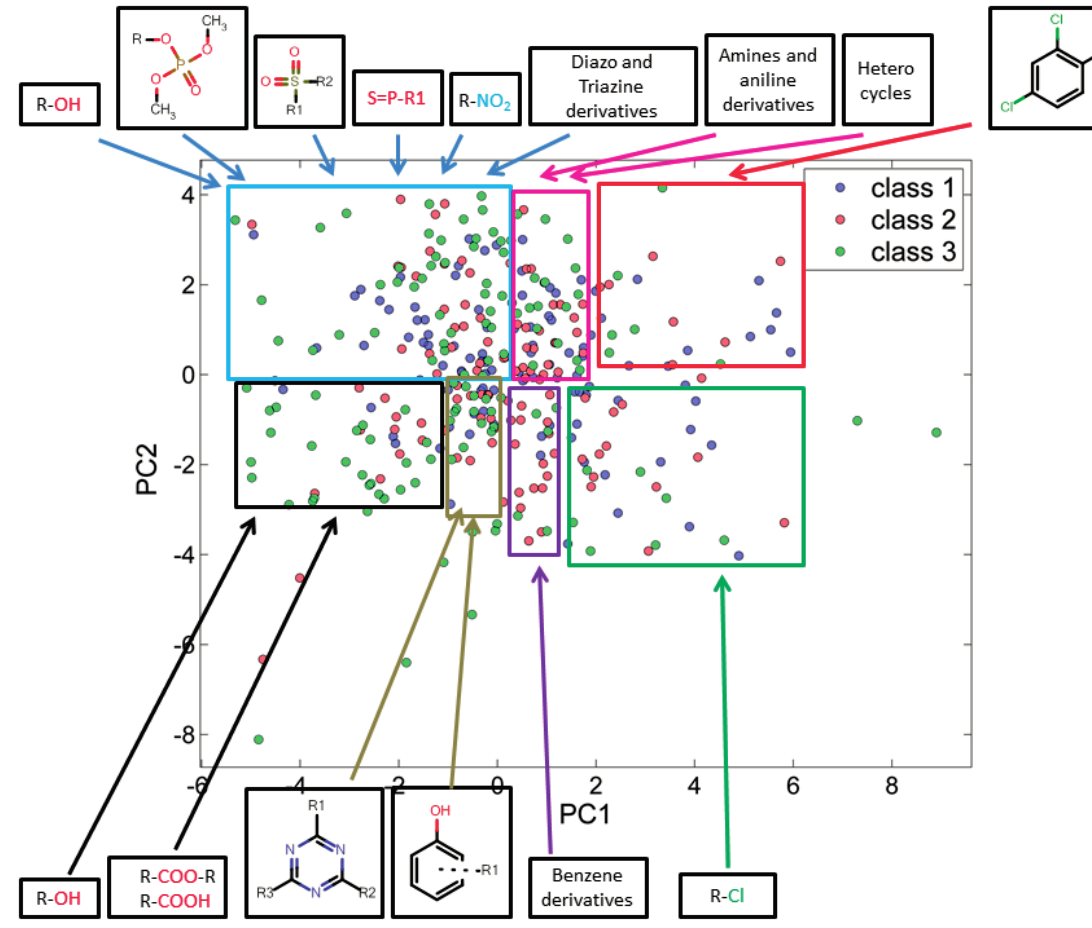
Figure 1. PCA score plot using 25 descriptors explaining similarity and variability in training set chemicals with respect to their corresponding